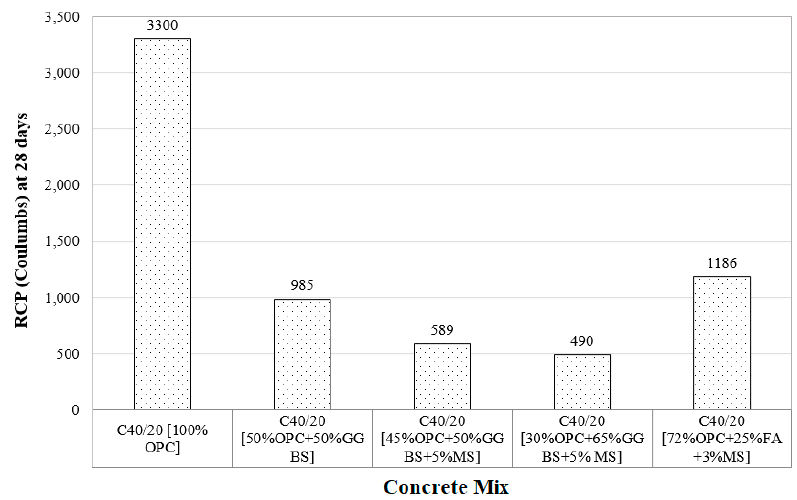
Figure 7. Average 28 day RCP result in accordance with ASTM C1202 for all investigated mixtures.